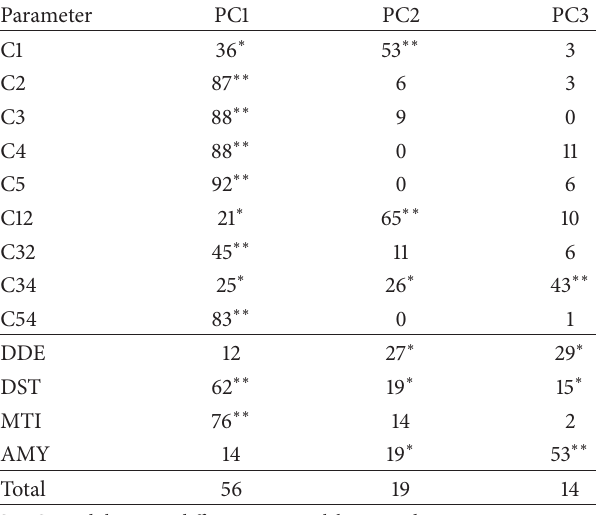
Table 4: Proportion (%) of explained variation by first three principal components